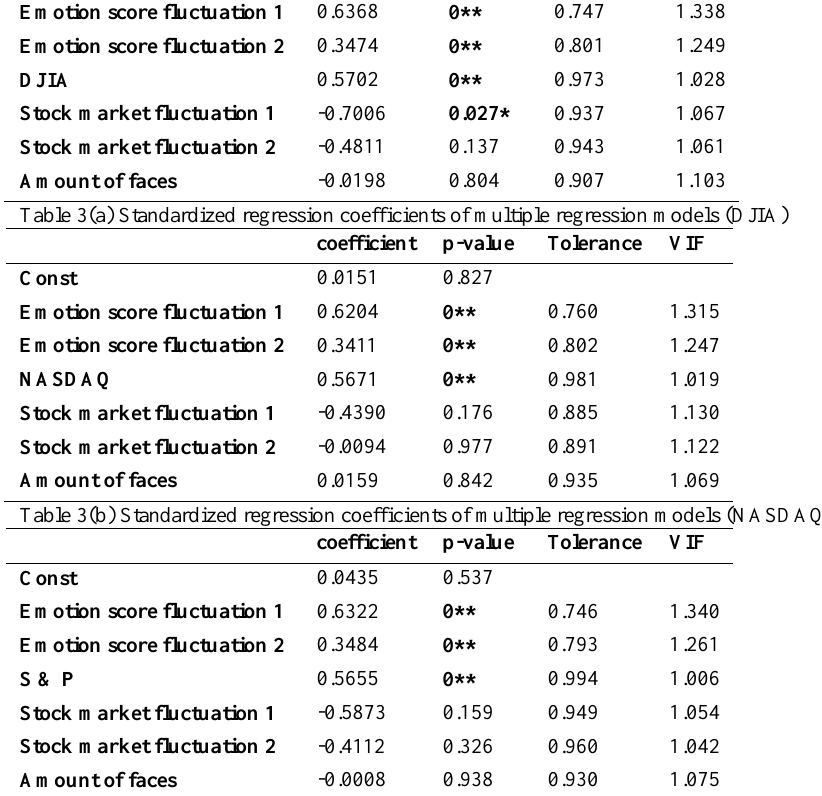
Table 3(c) Standardized regression coefficients of multiple regression models (S & P)